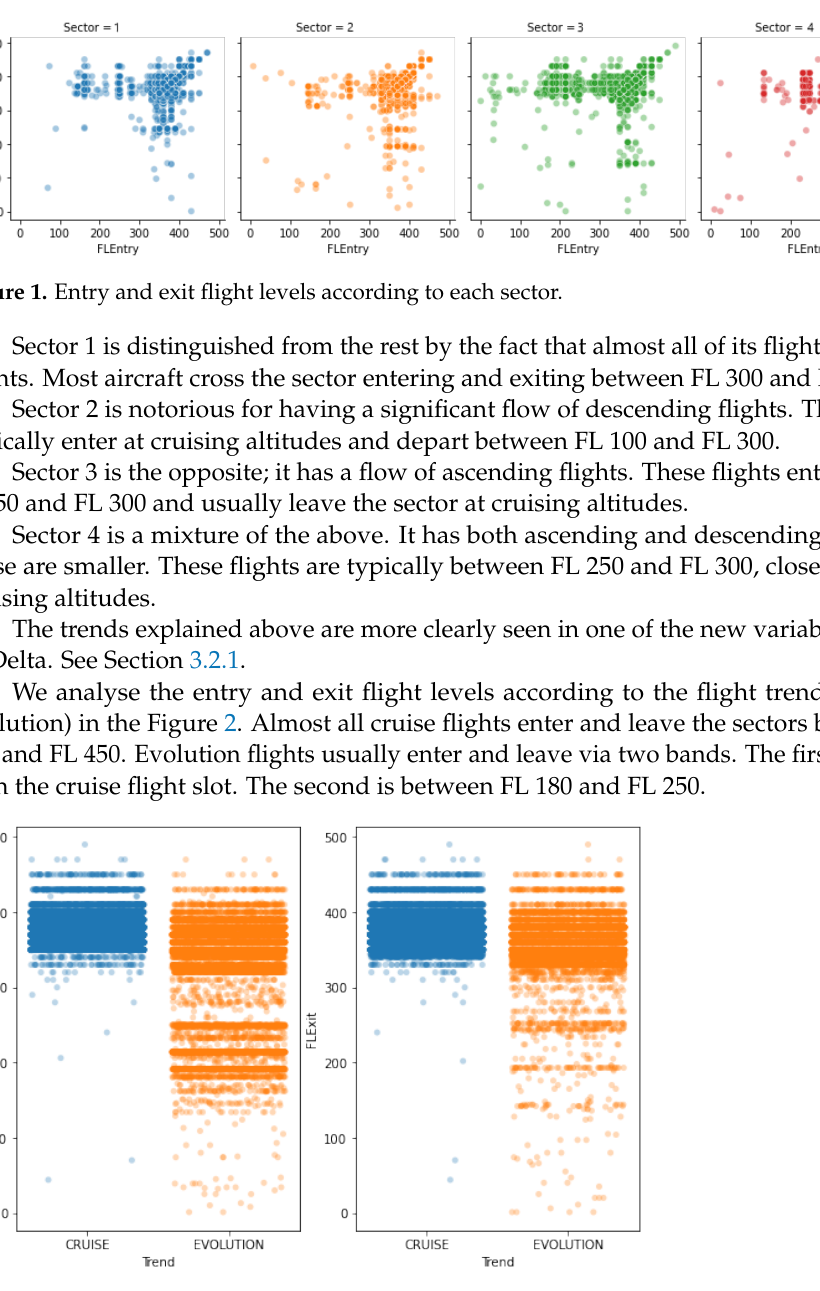
Figure 2. Representation of the entry and exit flight levels depending on the flight